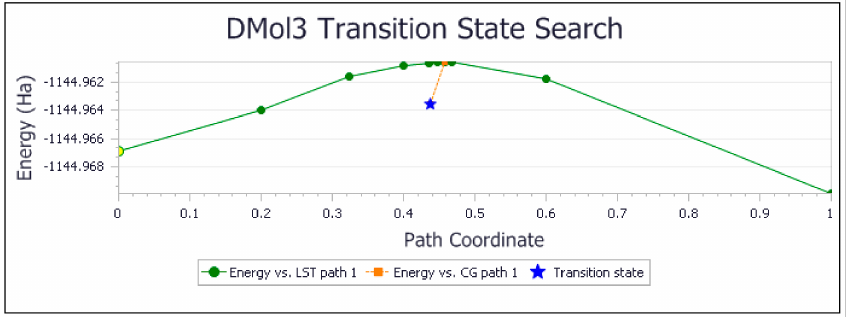
Figure 16. The DFT reactivity between H(4)Homobutein and superoxide shows capture of H4(hydroxy) by the radical, characterized by a transition state, ∆ G of − 1.9 kcal/mol, E(barrier) of 2.1 kcal/mol.